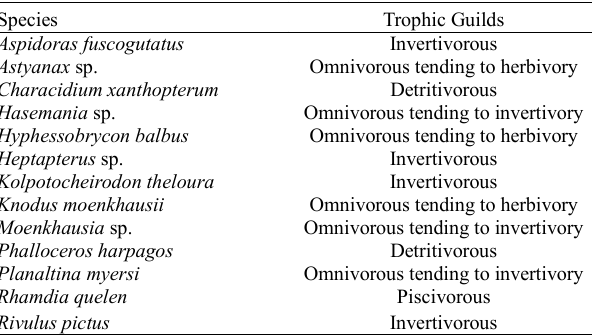
Table 5. Trophic guilds of the 13 species of fish with n>5 recorded for the Bananal stream subbasin, Paranoá Lake Basin,